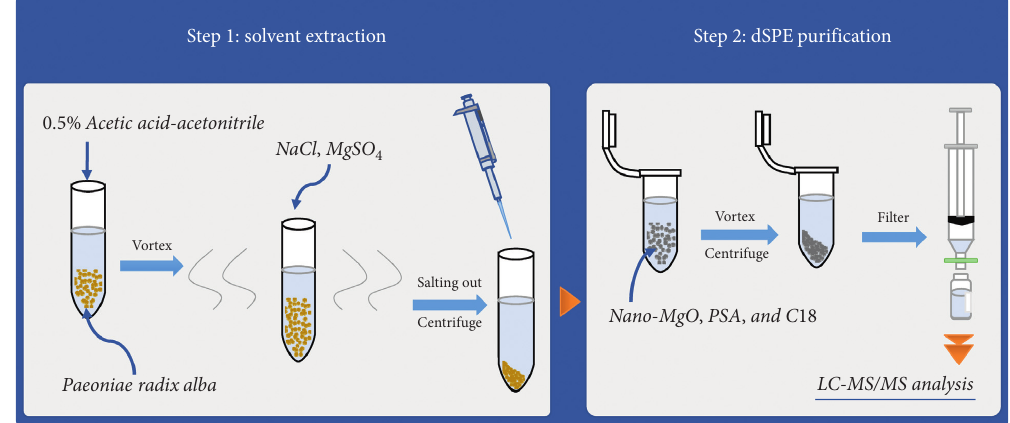
Figure 1: The scheme of the established pretreatment method